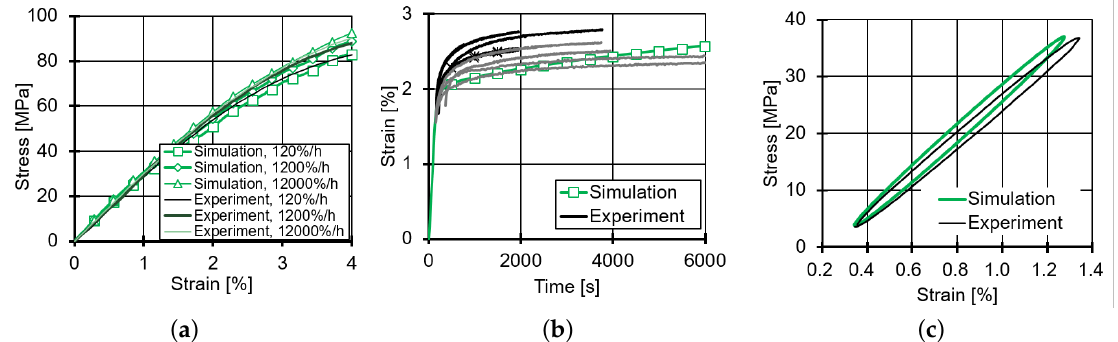
Figure 8. ( a ) Stress-strain relation of bulk resin in tension tests under different strain rates at 23 ◦ ; ( b ) progress of strain of bulk resin under creep loading with 43 MPa at 50 ◦ ; ( c ) stress-strain relation of a UD-layer under cyclic longitudinal shear loading with R = 0.1 at 25 ◦